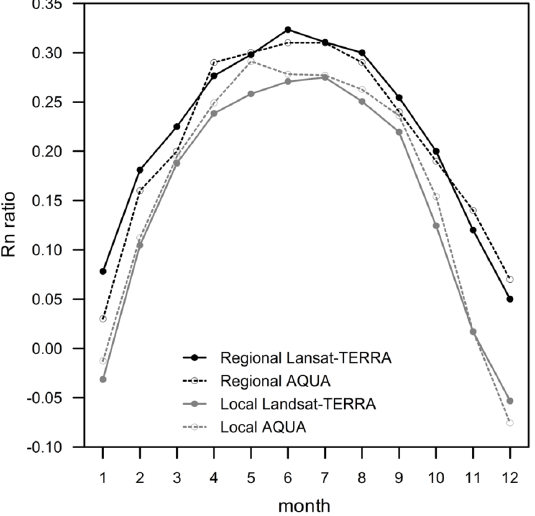
Fig. 3. Mean monthly local and regional R n at the Landsat/TERRA Figure 3. Mean monthly local and regional R n at the Landsat/TERRA and AQUA 2 and AQUA satellite pass on clear sky days from 2003 to 2005. satellite pass on clear sky days from 2003 to 2005. 3